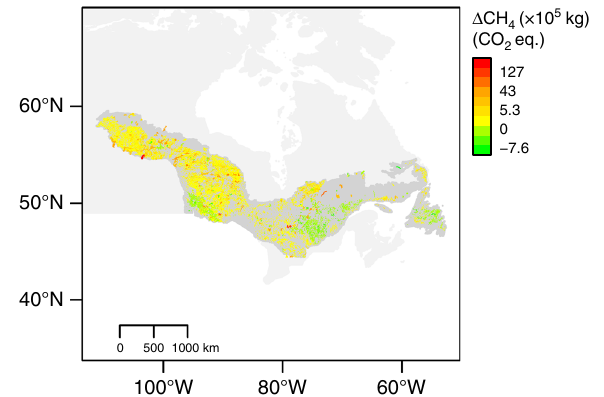
Fig. 4 Predicted increase in CH 4 production across the Boreal Shield. An increase of at least 73% is predicted because of the greater probability of occurrence of Typha latifolia alone. Estimated change in production is shown here as change in total kg of CH 4 (CO 2 equivalents) from current (1971 – 2001) to future (2041 – 2070) over a 150-day growing season in